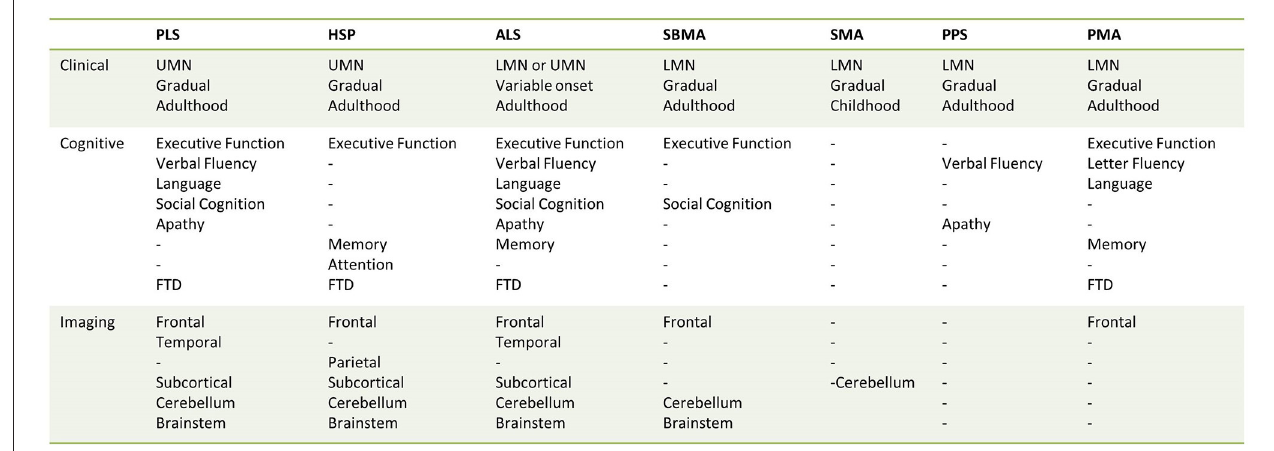
FIGURE 2 | Anatomical vulnerability and clinical domains affected across the spectrum of motor neuron diseases.